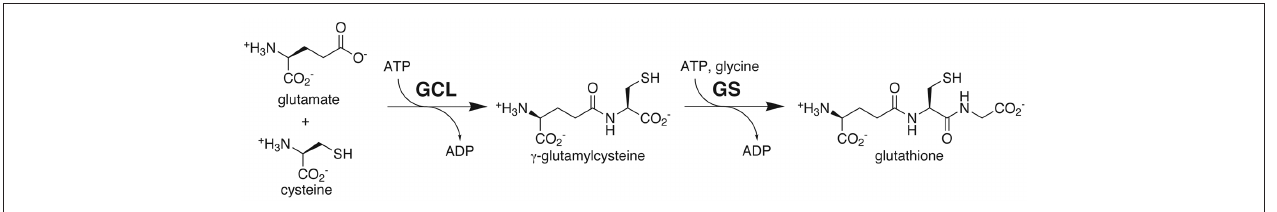
Figure 1 | glutathione biosynthesis. Substrates and products of the reactions catalyzed by glutamate-cysteine ligase (GCL) and glutathione synthetase (GS) are